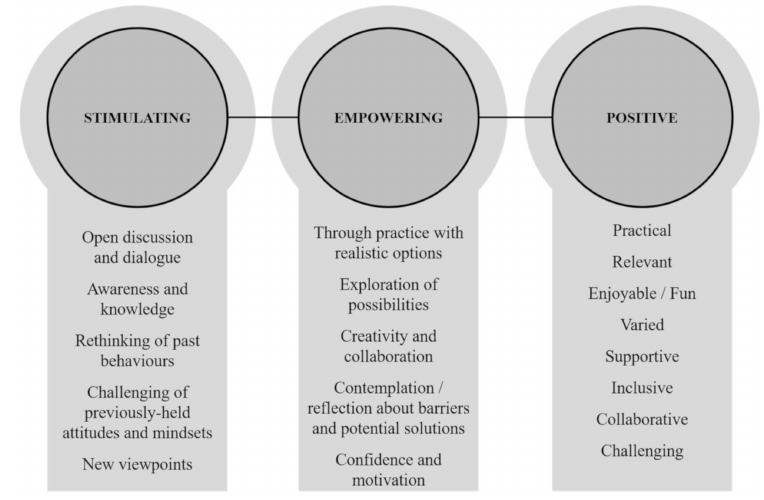
Figure 2. Participants’ appraisal of the Forum Play